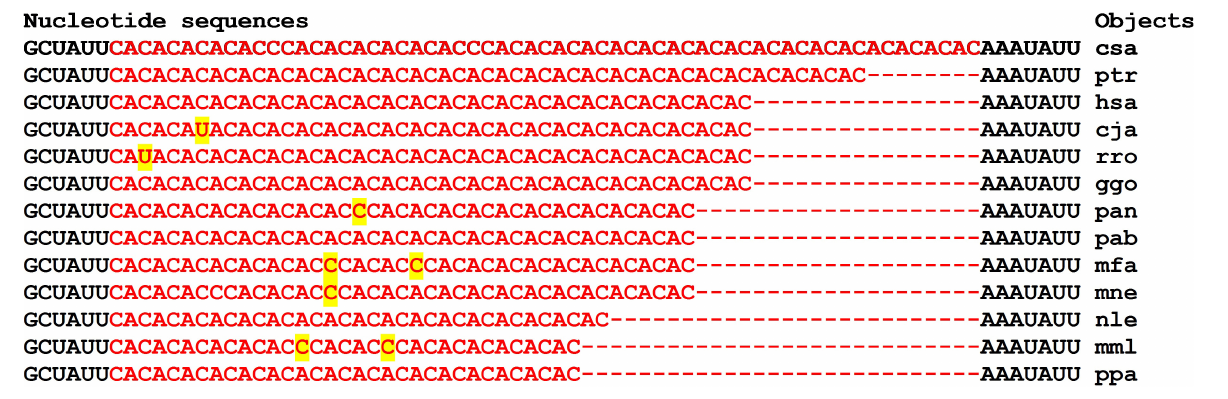
FIGURE 15 | Nucleotide sequences of 3 (cid:48) UTR regions of mRNAs of orthologous VSNL1 genes containing clusters of miRNAs binding